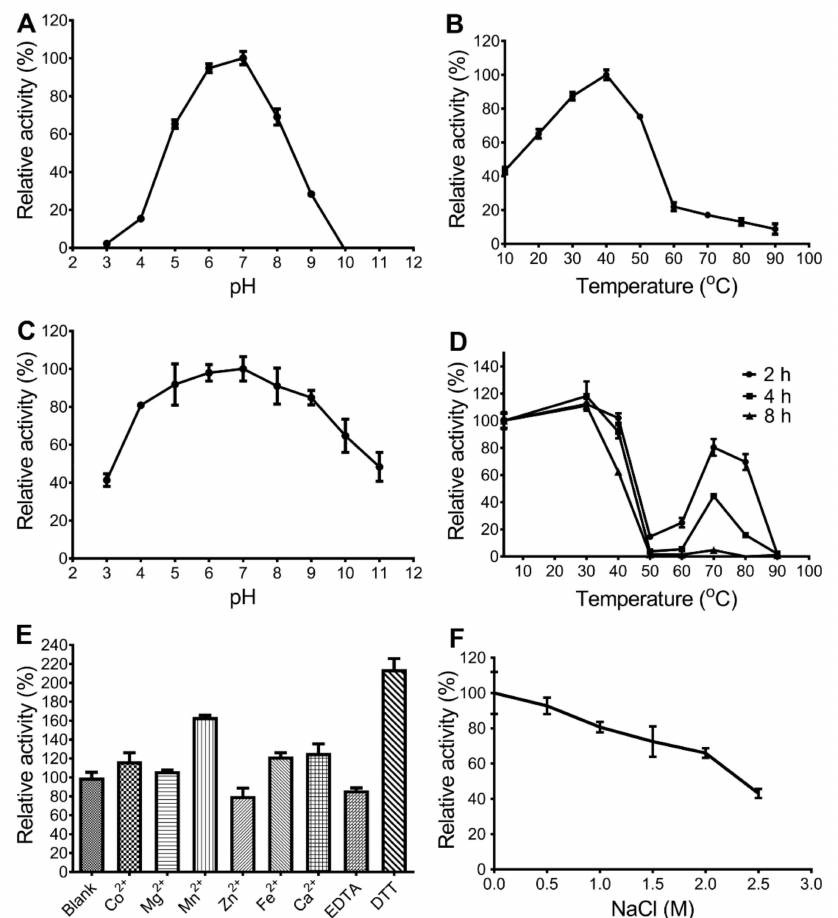
Figure 4. E ff ects of pH, temperature, and additives on the activity of Ca Aga1. Agarase activity was measured with 0.2% agarose as the substrate. ( A ) Optimal pH of Ca Aga1. The pH profile was measured at 40 ◦ C and di ff erent pH ranges (3–8: citrate-phosphate bu ff er; 9–11: 50 mM glycine-NaOH bu ff er). ( B ) Optimal temperature of Ca Aga1. The temperature profile was assayed at temperatures ranging from 10 ◦ C to 90 ◦ C in a citrate-phosphate bu ff er (pH 7). ( C ) pH stability of Ca Aga1. The pH stability